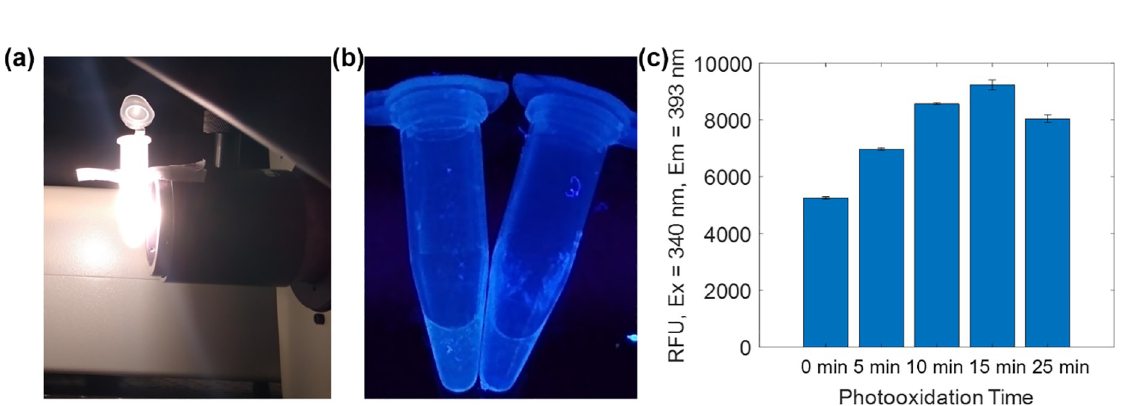
Fig 6. (a) Preparation of fluorescent peptide by photooxidation over high-power halogen lamp. (b) Fluorescent peptides over UV trans- illuminator. (c) Fluorescence intensities of peptides after exposure to lamp.